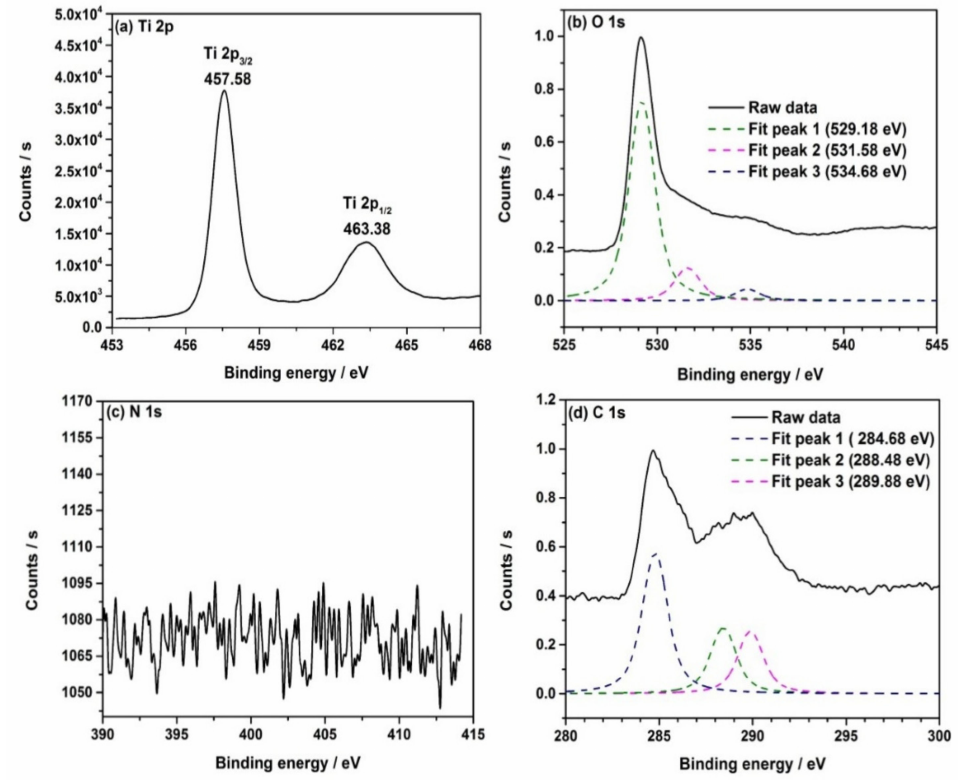
Figure 8. High resolution XPS spectra with peak fittings for pure TiO 2 sample showing: ( a ) Ti 2p, ( b ) O 1s, ( c ) N 1s, and ( d ) C 1s,